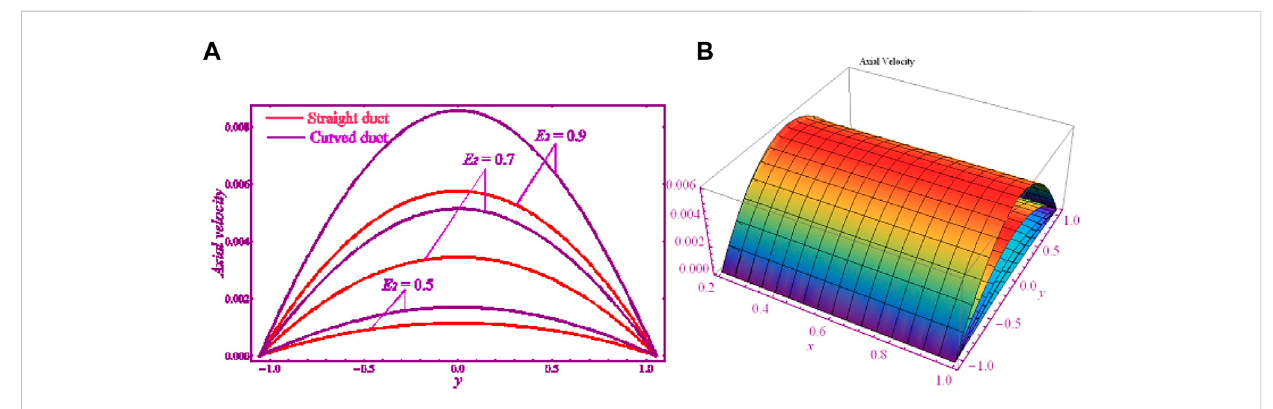
Axial velocity pro fi le for viscous damping force, E 2 . (A) 2D. (B)